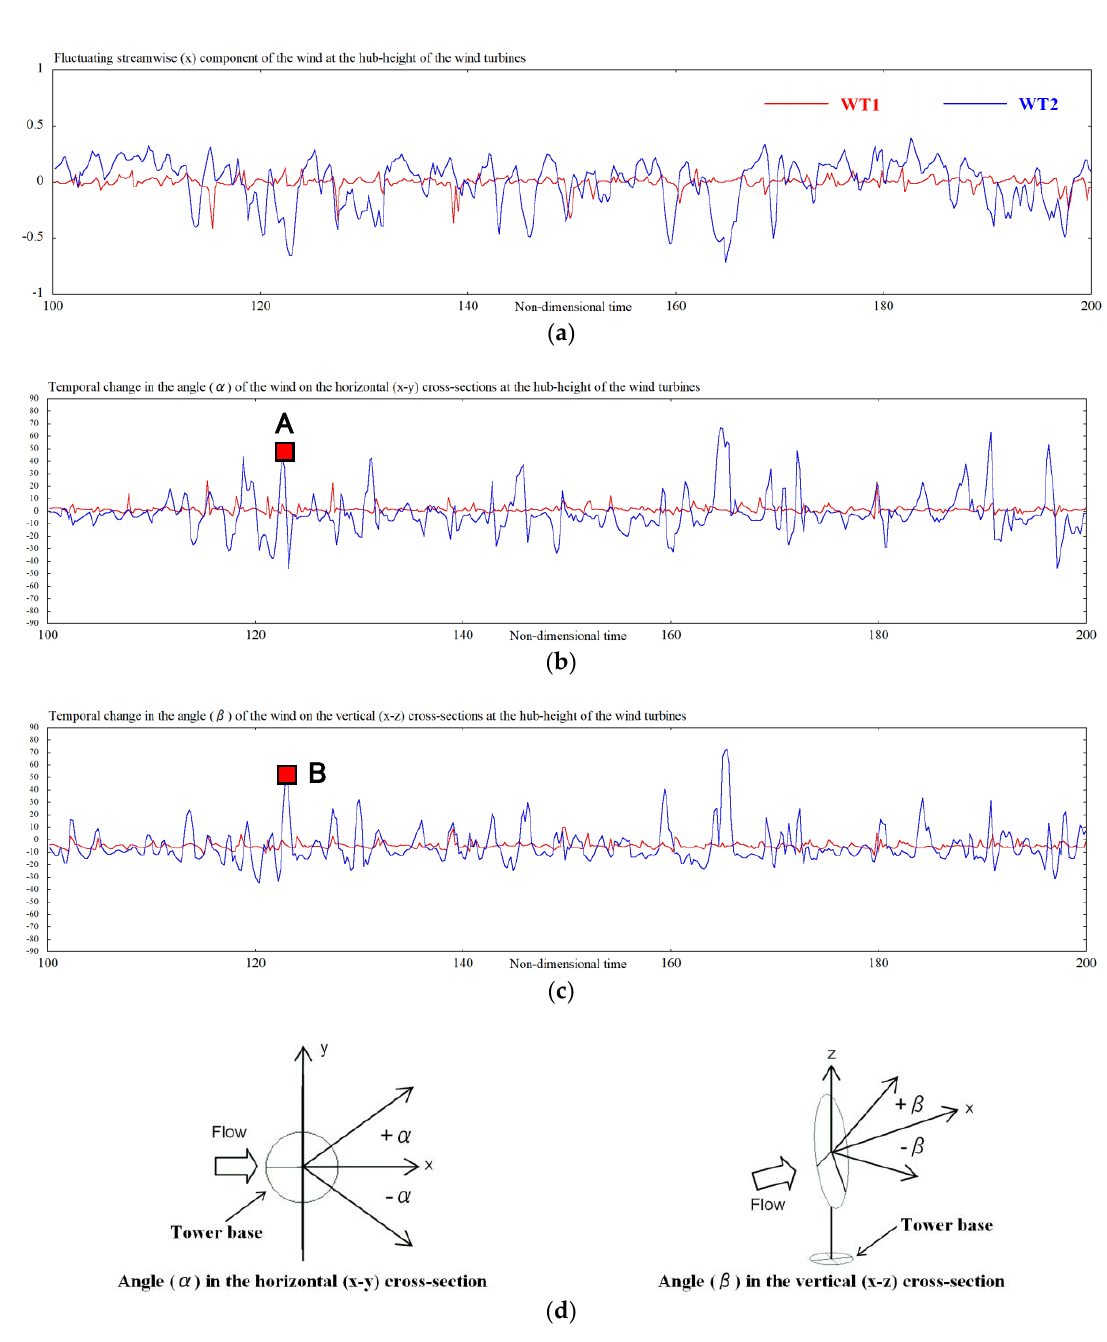
Figure 10. Fluctuating streamwise (x) component of the wind at the hub-height of the wind turbines (Figure 10a). Temporal change in the angle of the wind on the horizontal (Figure 10b) and vertical (Figure 10c) cross-sections at the hub-height of the wind turbines. Figure 10d also shows the definitions of the angles of the wind on the horizontal and vertical cross-sections. With an assumed wind speed of U in = 5.0 m/s, the time period on the horizontal axes is equivalent to approximately 40.0 min.